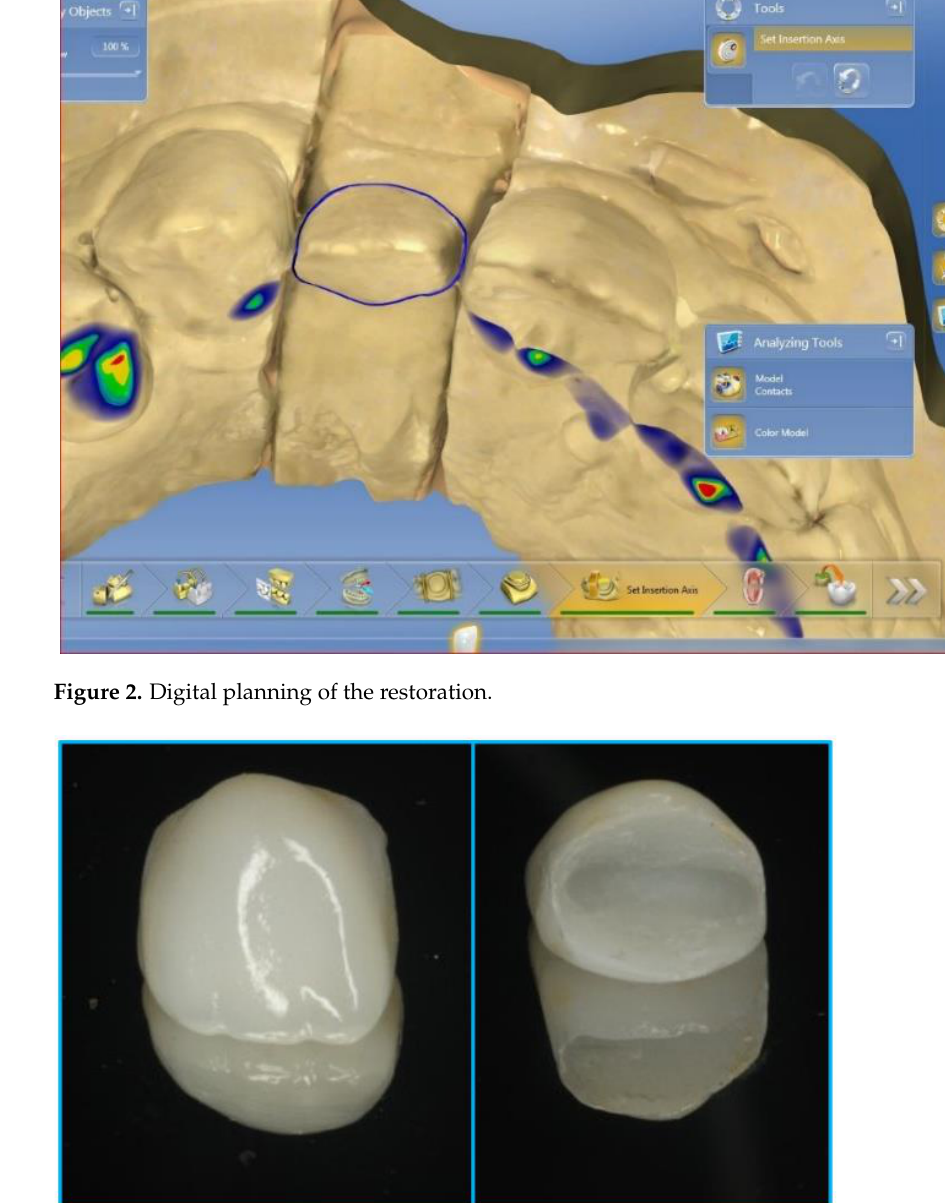
Figure 3. Anterior incisal onlay (AIO) Bilayer restoration — lithium disilicate veneered by feldspathic porcelain.